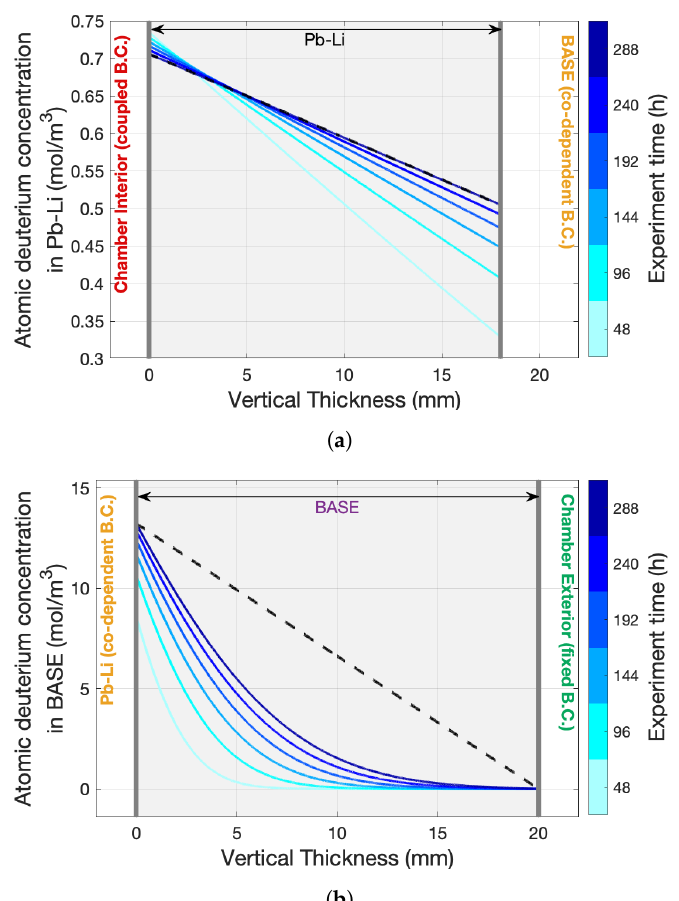
Figure 13. Simulation of concentration profiles evolution during 288 hours in Pb-Li and BASE steel media, using avg dissolution parameters ( vide Tables 1 and 3). Initial gas pressure set at 780mbar, heater temperature set at 450 ◦ C. ( a ) Concentration profile evolution in Pb-Li. Coupled BC (left) visibly decreases because the continued diffusion eventually reduces the amount of gas available in the UC in meaningful quantities. ( b ) Concentration profile evolution in BASE. Concentration maximum in the order of 13mol/m 3 . Notice how this value is lower than the maximum in Figure 6b, even after a much longer period of system